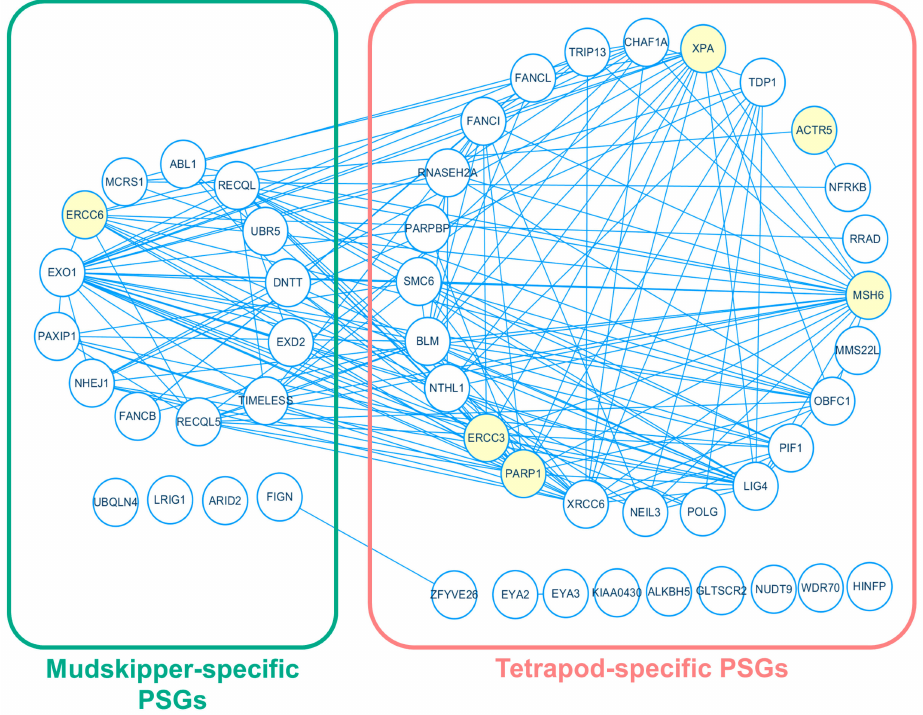
Figure 4. Protein-protein interaction network between tetrapod-specific and mudskipper-specific PSGs involved in “DNA repair”. Green and red indicates mudskipper-specific and tetrapod-specific PSGs, respectively. Yellow indicates the six PSGs involved in “response to